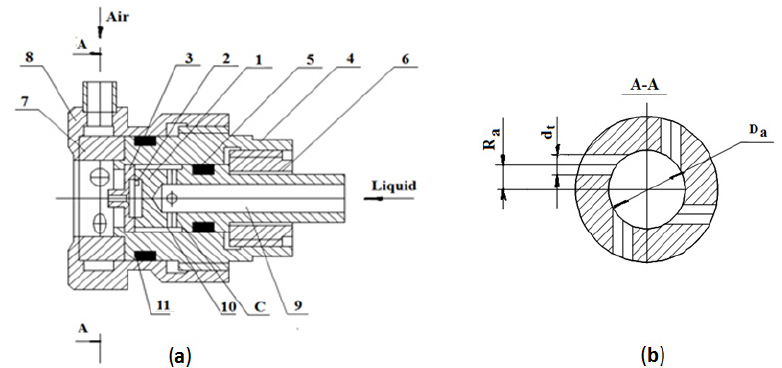
Figure 2. Design of an air-assisted atomizer. ( a ) Atomizer assembly: 1—swirl chamber, 2—grooves, 3—nozzle, 4—body, 5, 11—sealing ring, 6—nut, 7—bush, 8—adapter, 9—tip, 10—radial channels. ( b ) Cross section of the air swirl